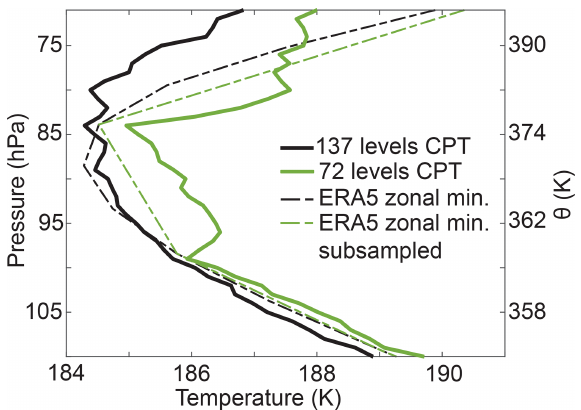
Figure 7. Temperature profiles of the DJF 2017 mean trajectory cold points measured by full (137-level) resolution and 72-level vertical resolution trajectories (solid lines), and the ERA5 time- averaged JF 2017 zonal minimum cold point temperature taken from the full grid (dashed black line) and the 72-level vertical grid (dashed green line). The left axis is exact pressure from ERA5, and the right axis is the potential temperature calculated at those pres- sure levels with the DJF 2017 zonal mean temperature.